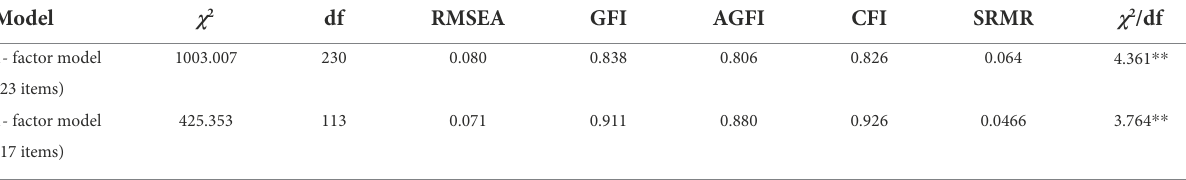
TABLE 2 Fit indices of standardized maximum likelihood estimates ( N = 554).